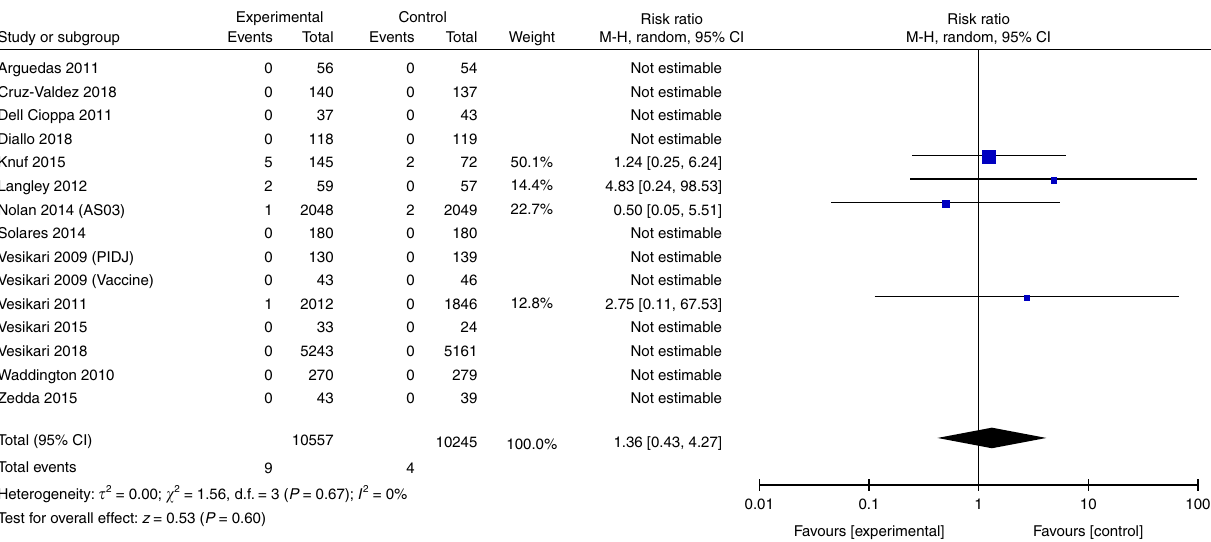
Fig. 10 Forest plot showing the risk ratios of neurological events during the follow-up time (ranging from 21 to 390 days) after the vaccinations among children who received adjuvanted versus non-adjuvanted trivalent vaccines (TIVs) or quadrivalent vaccines